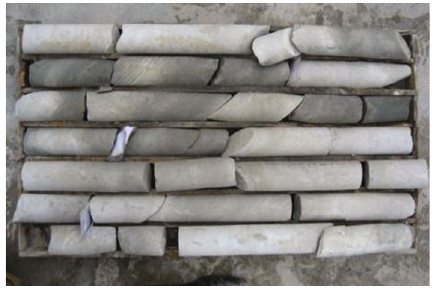
Figure 4: Back fi ll in GZK3 borehole.